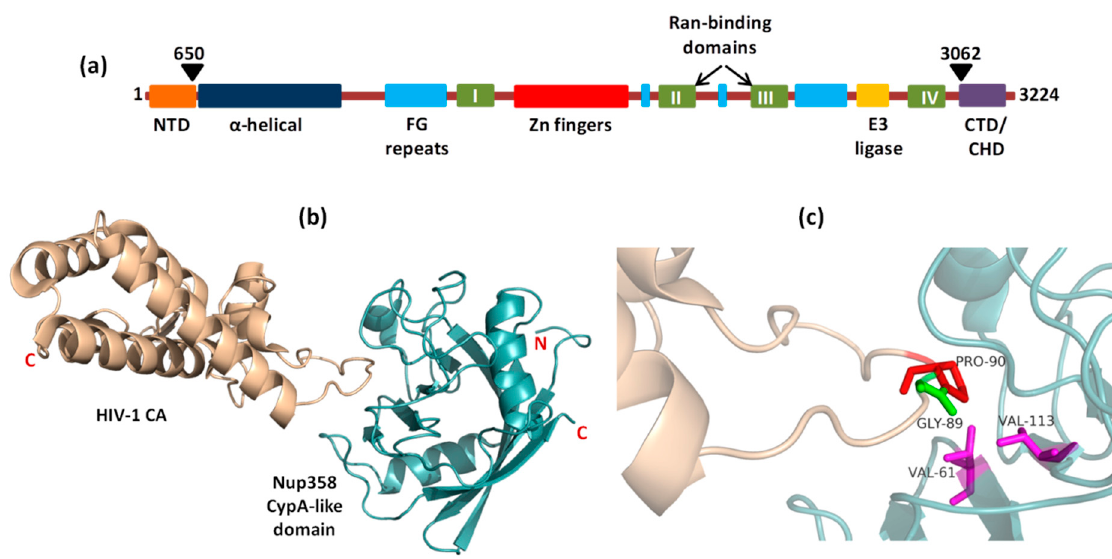
Figure 5. Complex of HIV-1 CA (wheat) and Nup358CypA (Cyan) (PDB code 4LQW): ( a ) Domain architecture of human Nup358 ( b ) Loop of HIV-1 CA bound in cleft of Nup358CypA; ( c ) Val61 and 113 which form the hydrophobic pocket in Nup358 CHD, interact with Gly89 and Pro90 of Cyp binding loop in HIV-1 CA.